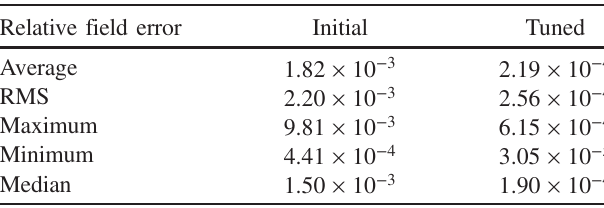
TABLE VI. Relative field error